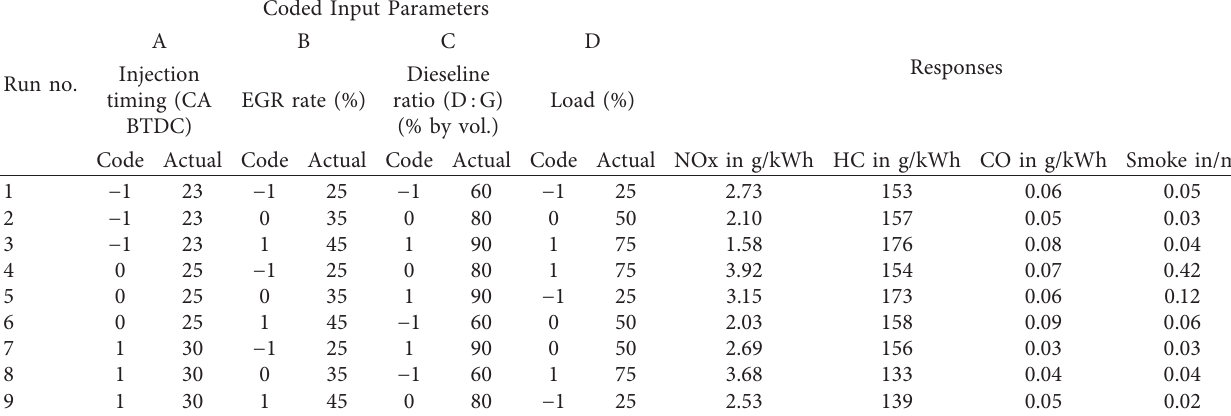
Table 5: L 4 ) Factors and responses in the orthogonal array test matrix. 9 (3